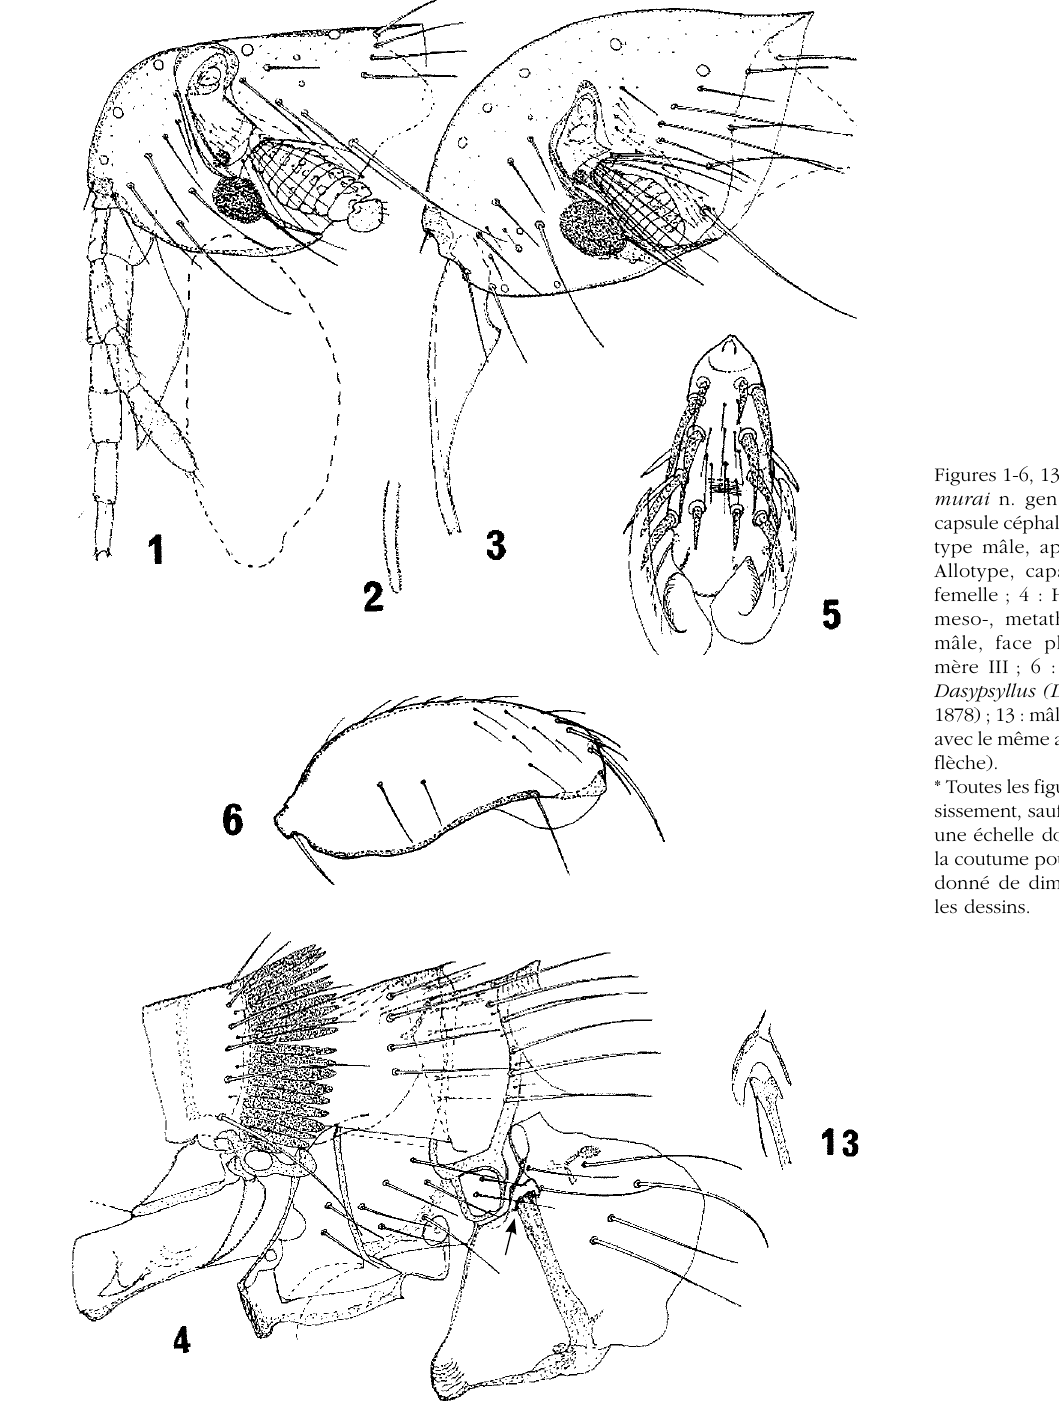
Pseudo-setae relativement longues. Quelques soies, pro- thoraciques et des premiers segments tergaux,